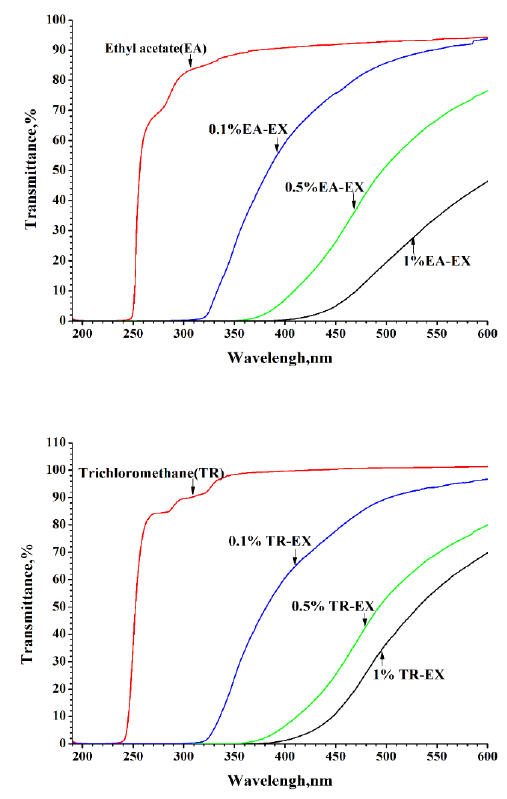
Figure 5. Transmittance spectra of solvents and the solvent diluted extract solutions.